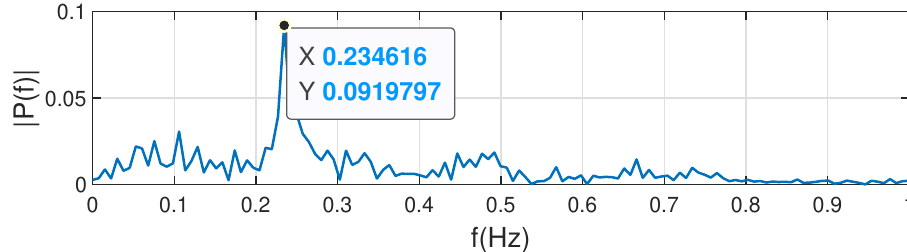
Figure 11. Respiratory rate